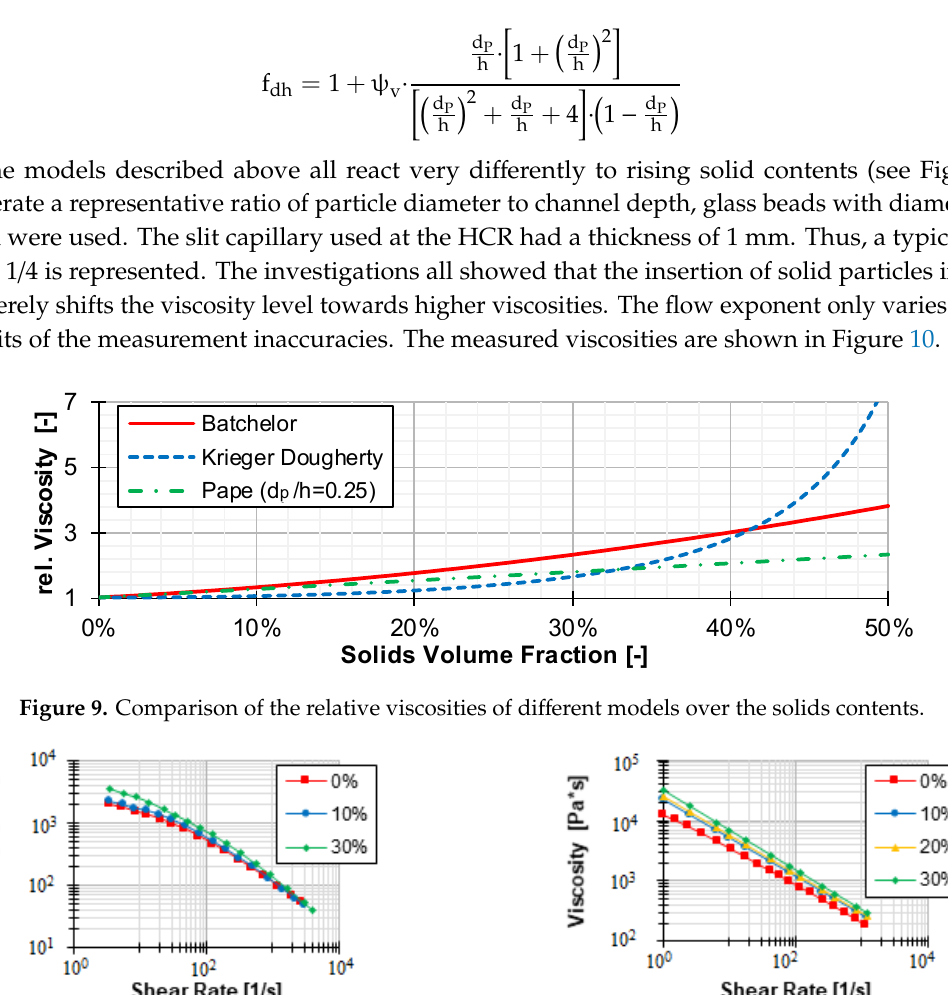
12 of 30 Figure 8. Schematic simplified representation of shear increase due to solid particles.